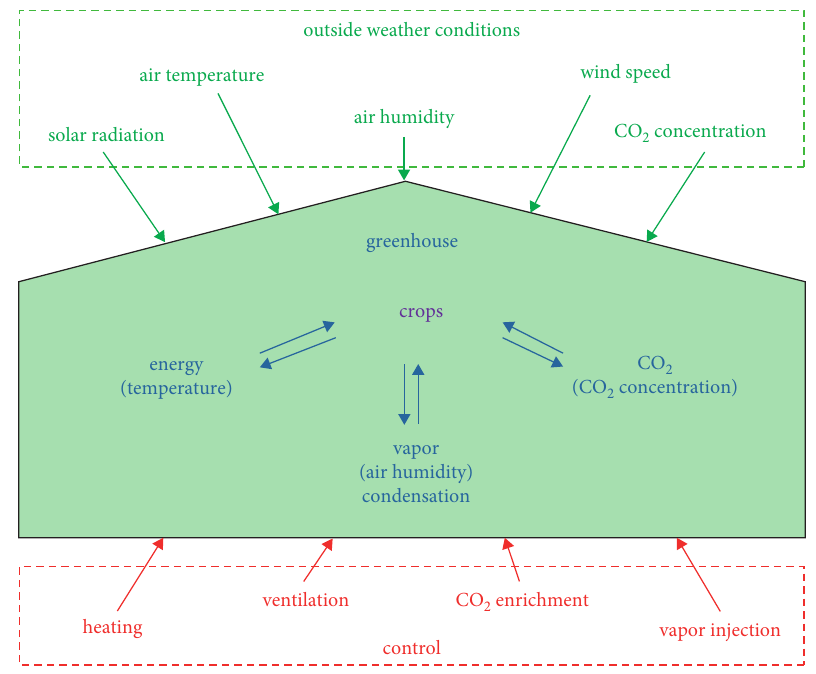
Figure 7: Scheme of greenhouse climate model (adapted from [2, 13, 14, 17, 32, 45, 46,